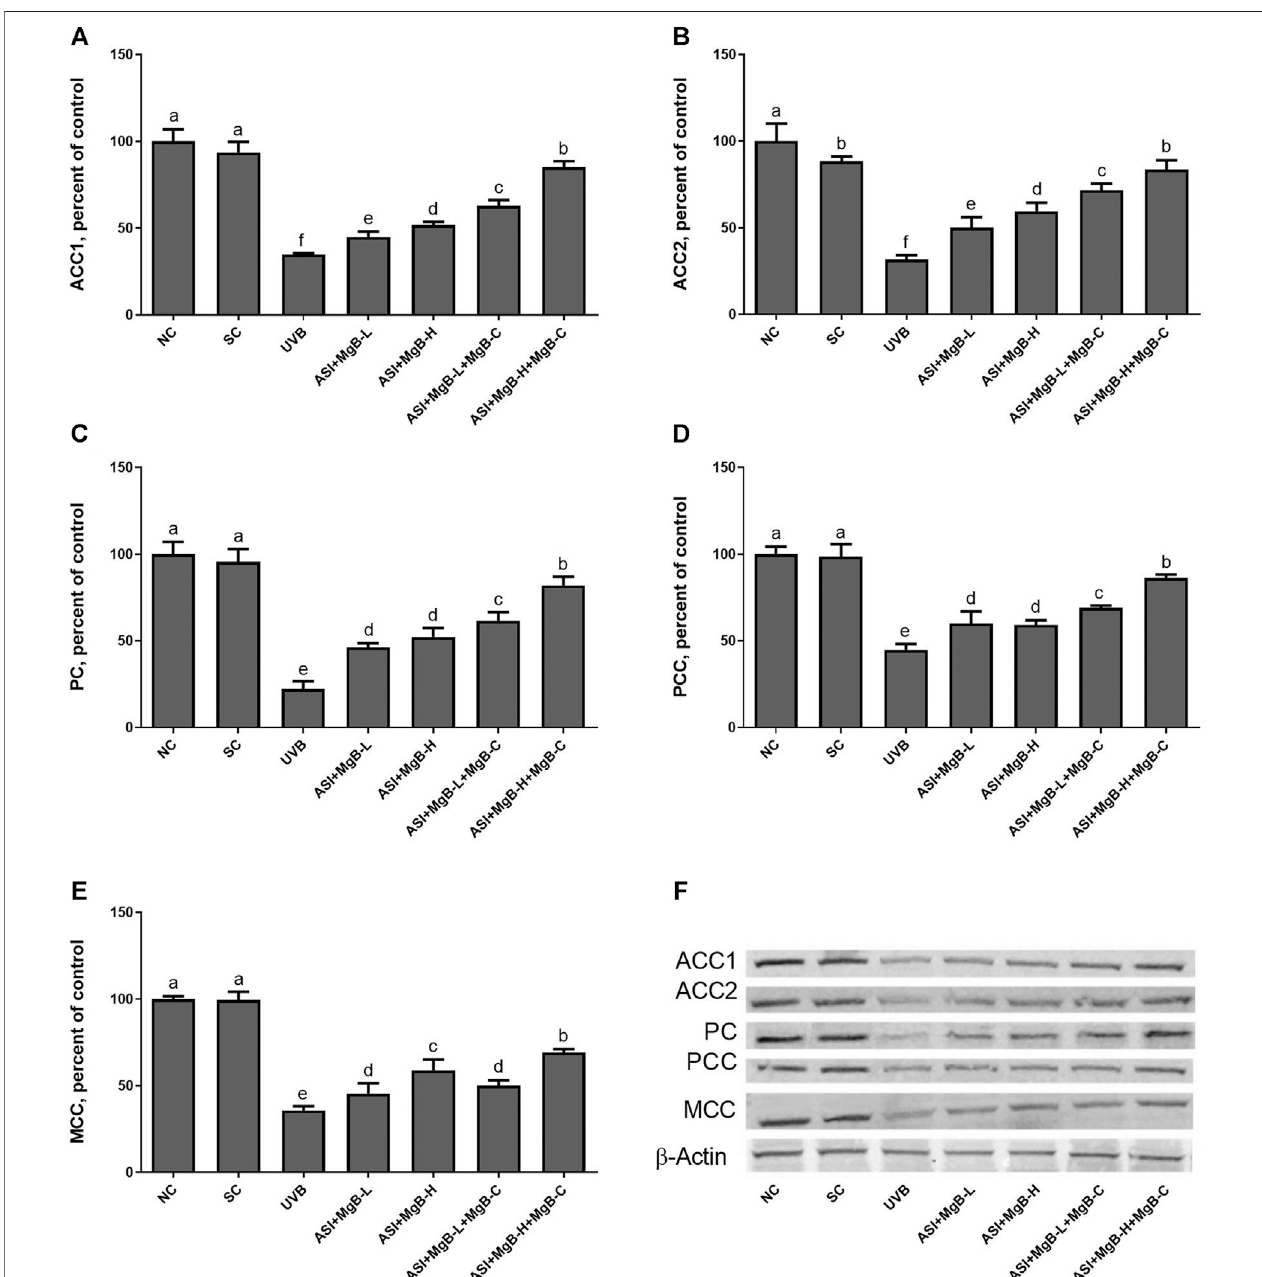
FIGURE 3 | Effect of inositol-stabilized arginine silicate complex (ASI) and magnesium biotinate (MgB) on acetyl CoA carboxylase 1 (ACC-1; A ), acetyl CoA carboxylase 2 (ACC-2; B ), pyruvate carboxylase (PC; C ), propionyl-CoA carboxylase (PCC; D ), 3-methylcrotonyl-CoA carboxylase (MCC; E ) protein levels in rats with UVB-induced photoaging. Data are expressed as a percent of the control value. Each bar represents the mean and standard error of the mean. Blots were repeated at least 3 times. Western blot analysiswasperformed withactin included ensuring equal protein loading (F) . a – f : Values within the bars with different superscripts are signi fi cantly different (One-way ANOVA and Tukey;s post-hoc test, p <